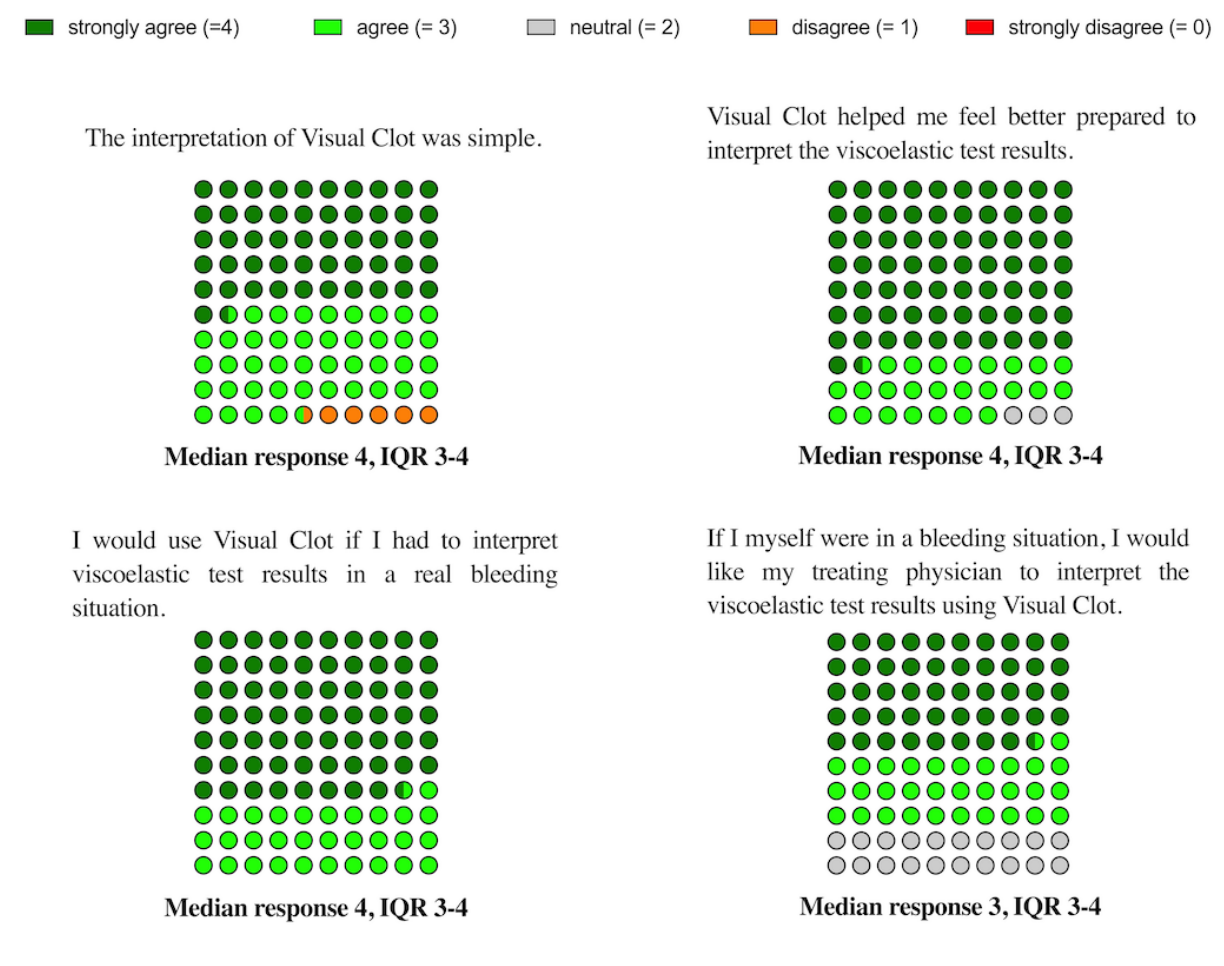
Figure 5. Graphical presentation of the participants’ rated survey statements as 10 x 10 parts of whole dot plots. Results are presented as median and IQR. N=35 in each rated